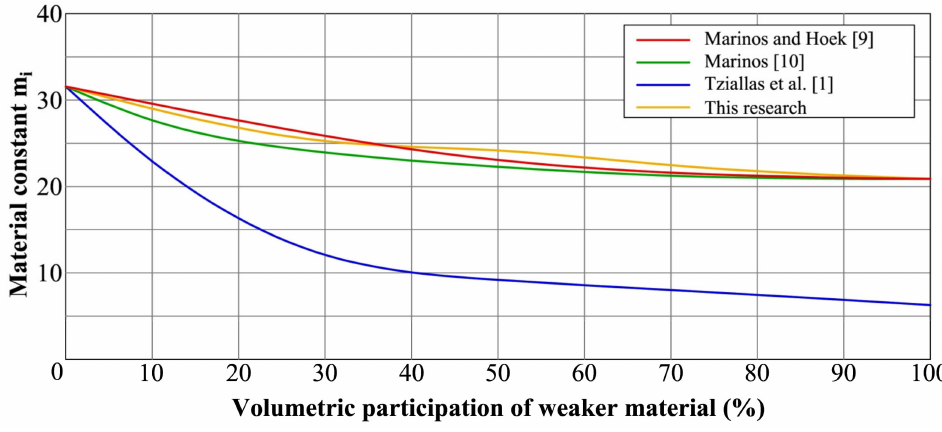
Figure 17. Comparison of the value material constant m i